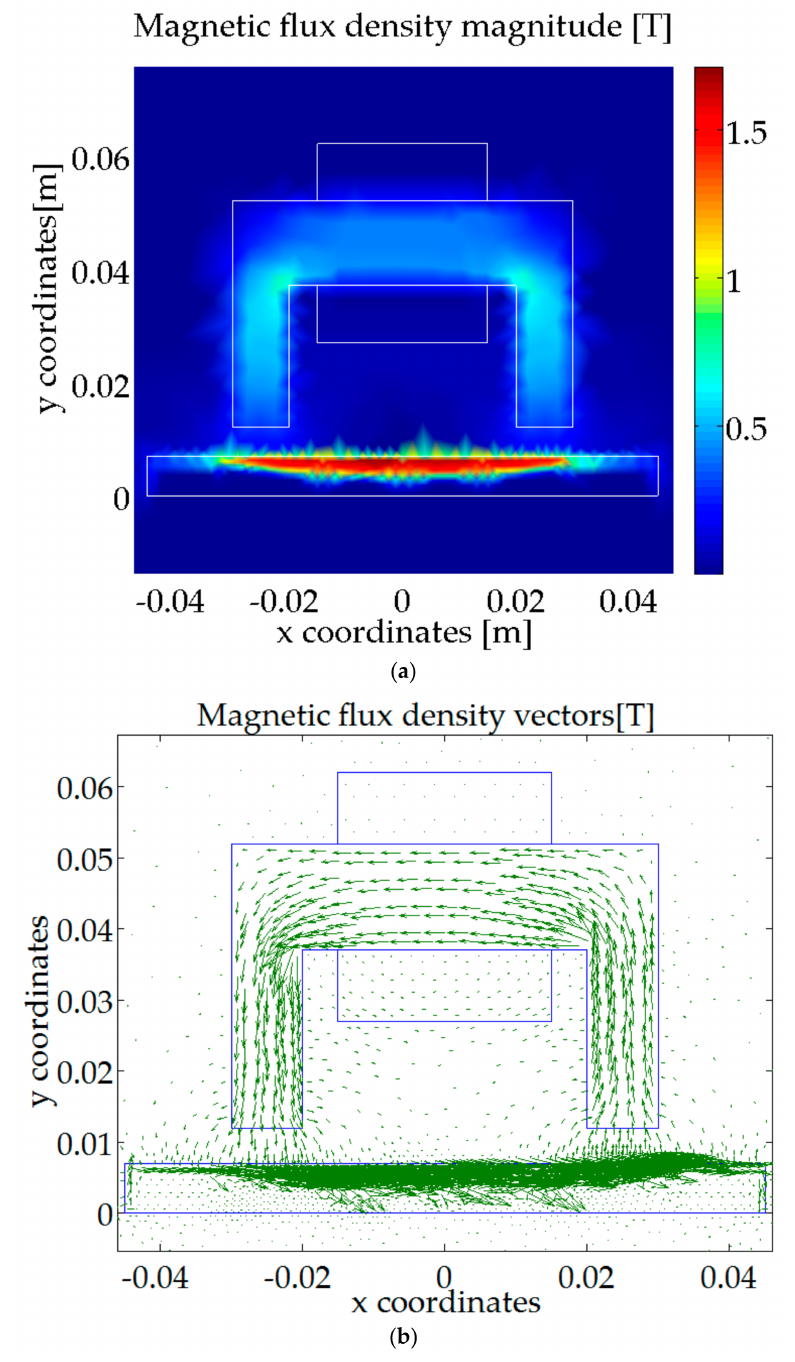
Figure 6. Steady state of the magnetic flux density: ( a ) spatial distribution, ( b ) vector field